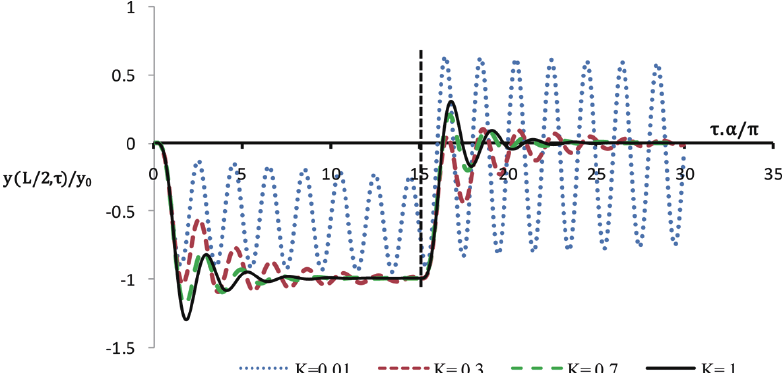
Fig. 7. DLF in terms of τ · α/π for α = 1, E 1 = 0.5 and K (cid:3) 1.